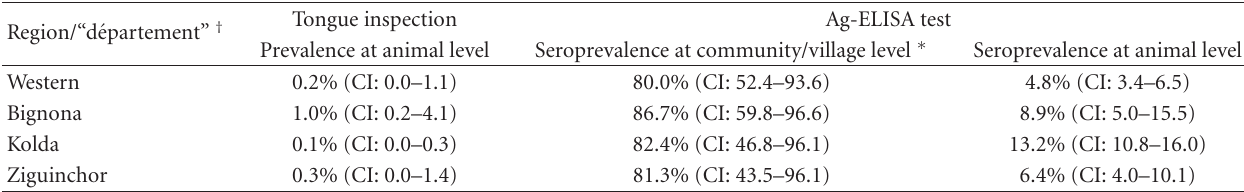
Table 2: Porcine cysticercosis prevalence by tongue inspection and seroprevalence by Ag-ELISA in four study areas in The Gambia and